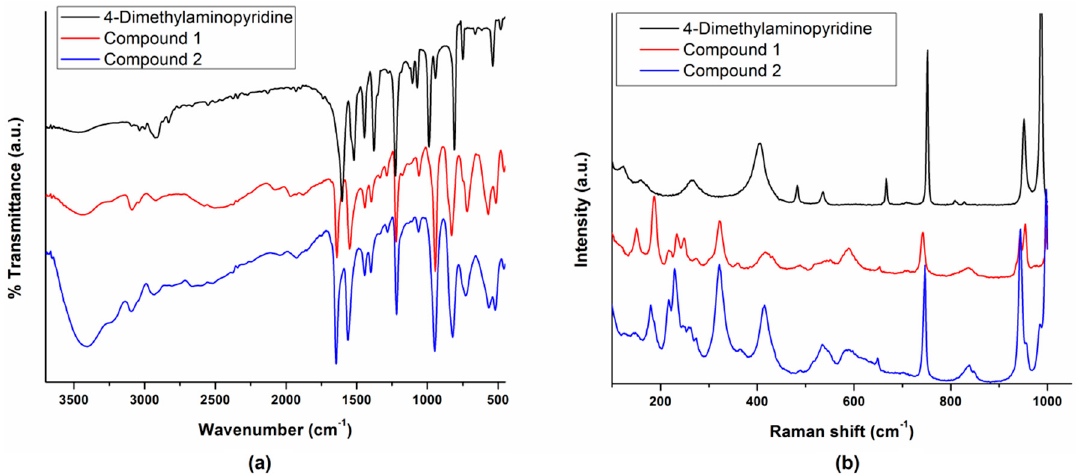
Figure 4. FT-IR ( a ) and Raman spectra ( b ) of 4-dimethylaminopyridine and their corresponding hydrated decavanadate salts 1 and 2 , ( a ) recorded in KBr pellets.